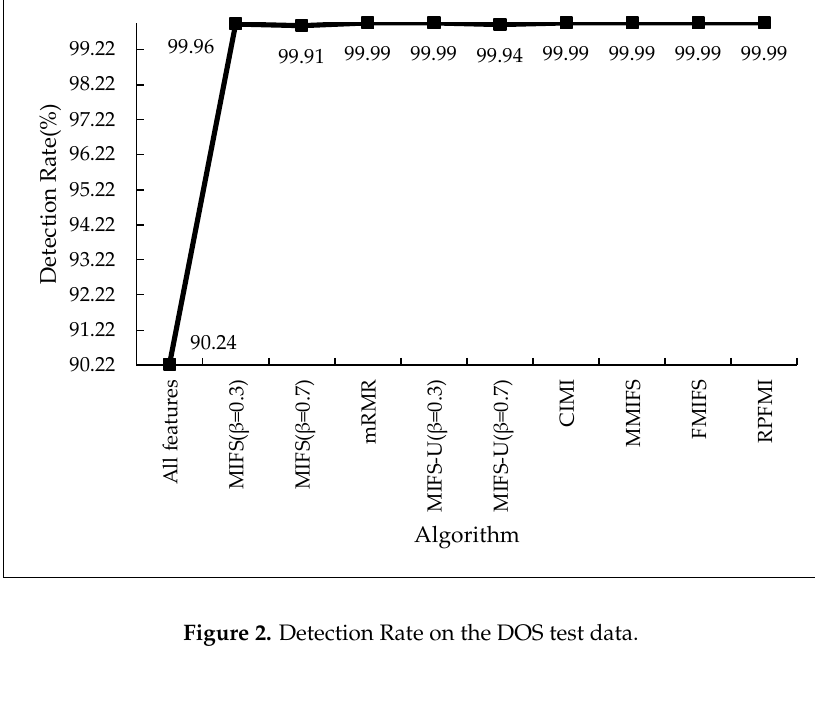
Figure 1. Accuracy on the DOS test data.